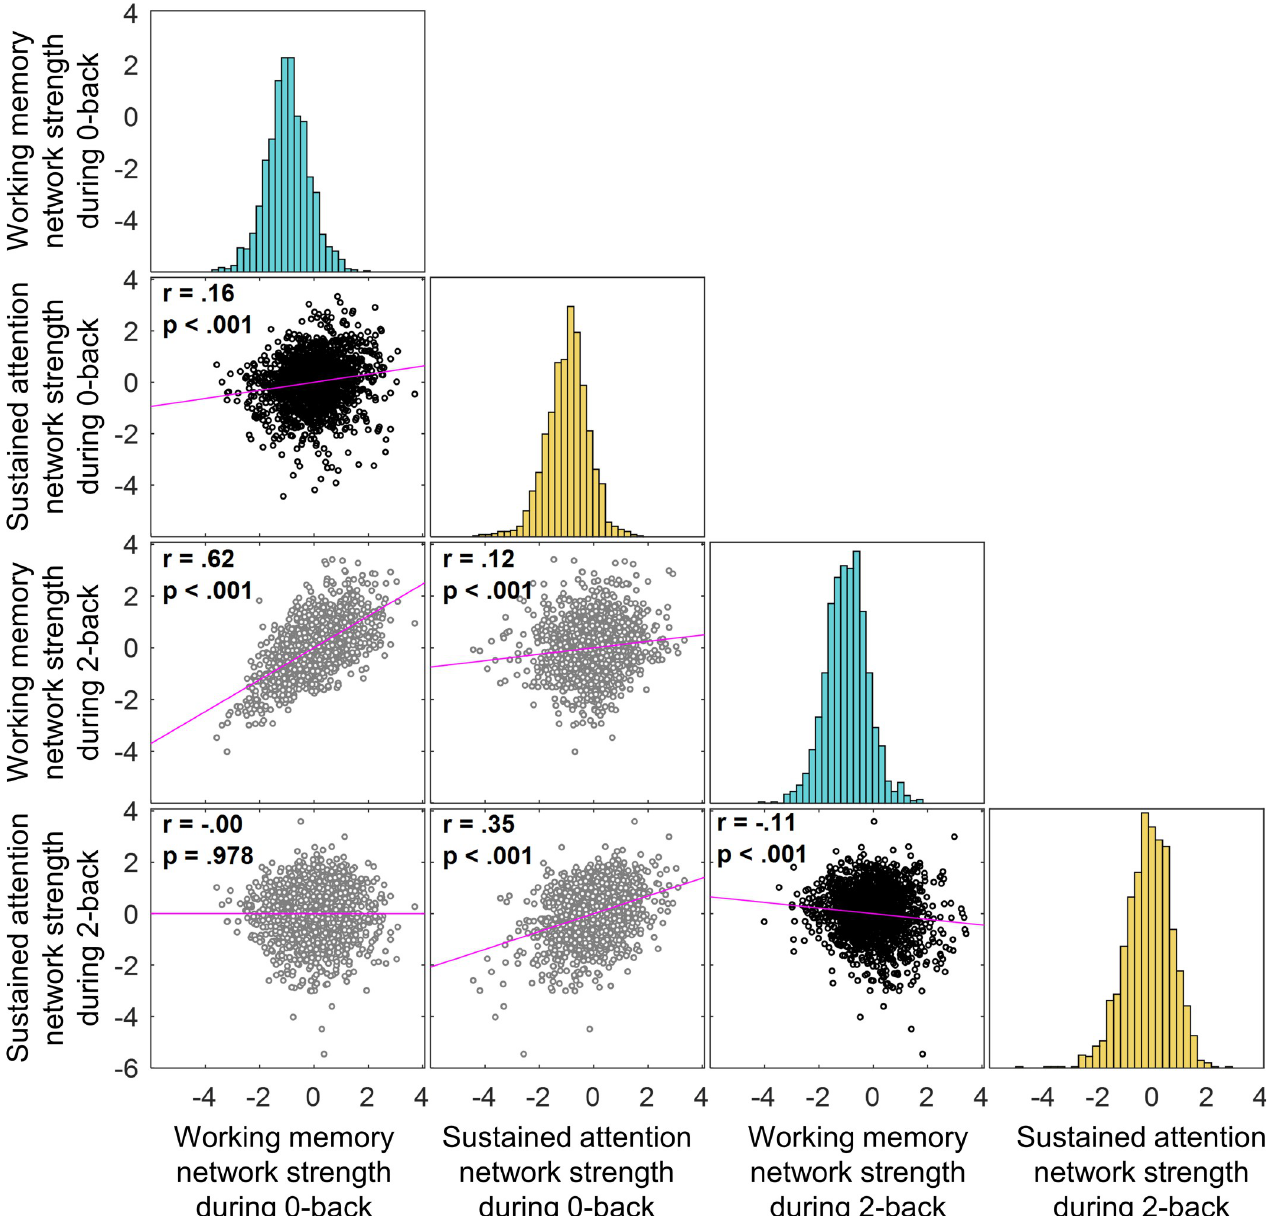
Fig 3. Network strengths across the participants and tasks. Correlations between predictive networks strength values across the participants in the 2-back task and 0-back tasks. Task-congruent relationships are shown in black scatterplots. The data for this figure are available at NDA study 1849 10.15154/1528288.